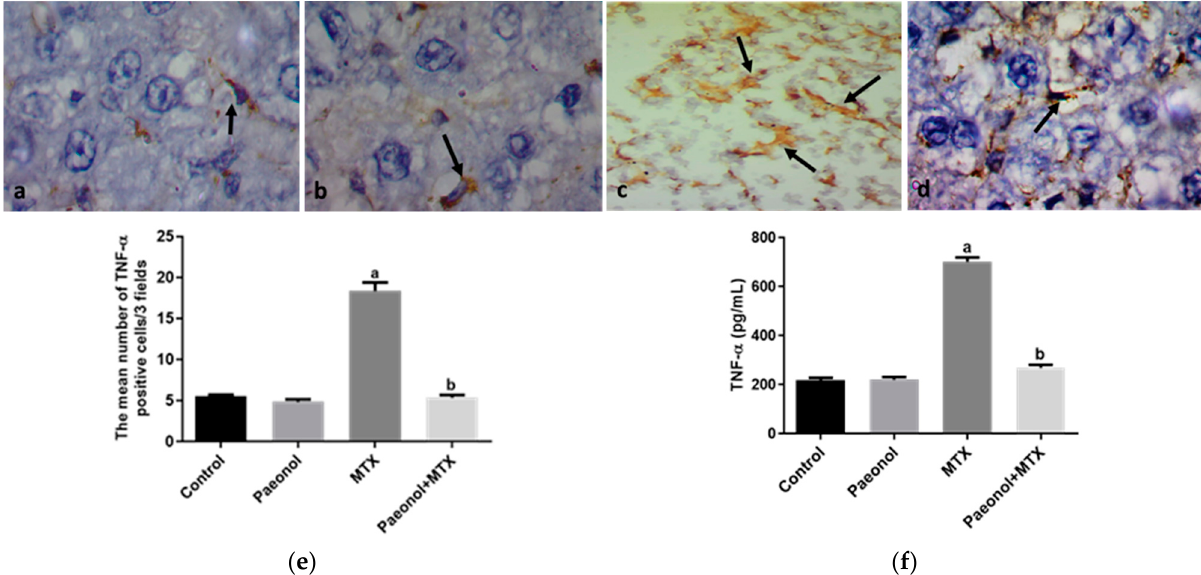
Figure 10. The immunohistochemical examination of hepatic tumor necrosis factor- α (TNF- α ) ex- pression in methotrexate (MTX)-induced hepatotoxicity (×1000). The liver tissues of the control ( a ) and paeonol ( b ) groups show Kupffer cells with TNF- α cytoplasmic expression (arrows). The liver tissues of the MTX-treated rats show many Kupffer cells with TNF- α cytoplasmic expression (ar- rows) ( c ). In contrast, the liver tissues of the paeonol + MTX group show few Kupffer cells with TNF- α cytoplasmic expression (arrow) ( d ). A semi-quantitative analysis of TNF- α positive cells ( e ). He- patic TNF- α level using TNF- α ELISA kit ( f ). Data are represented as mean ± SEM ( n = 6). Letters a,b Denote significant differences from the normal control and the MTX groups, respectively, at p ˂ 0.05.